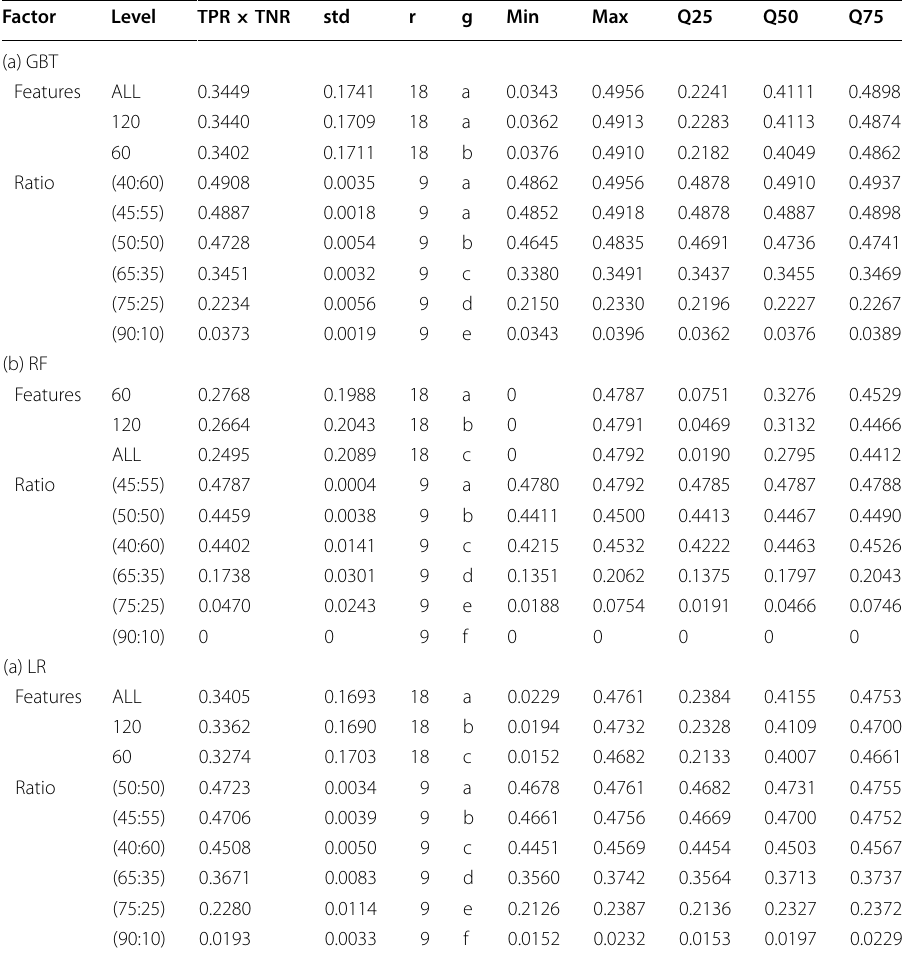
Table 5 Tukey HSD test—ECBDL’14 dataset